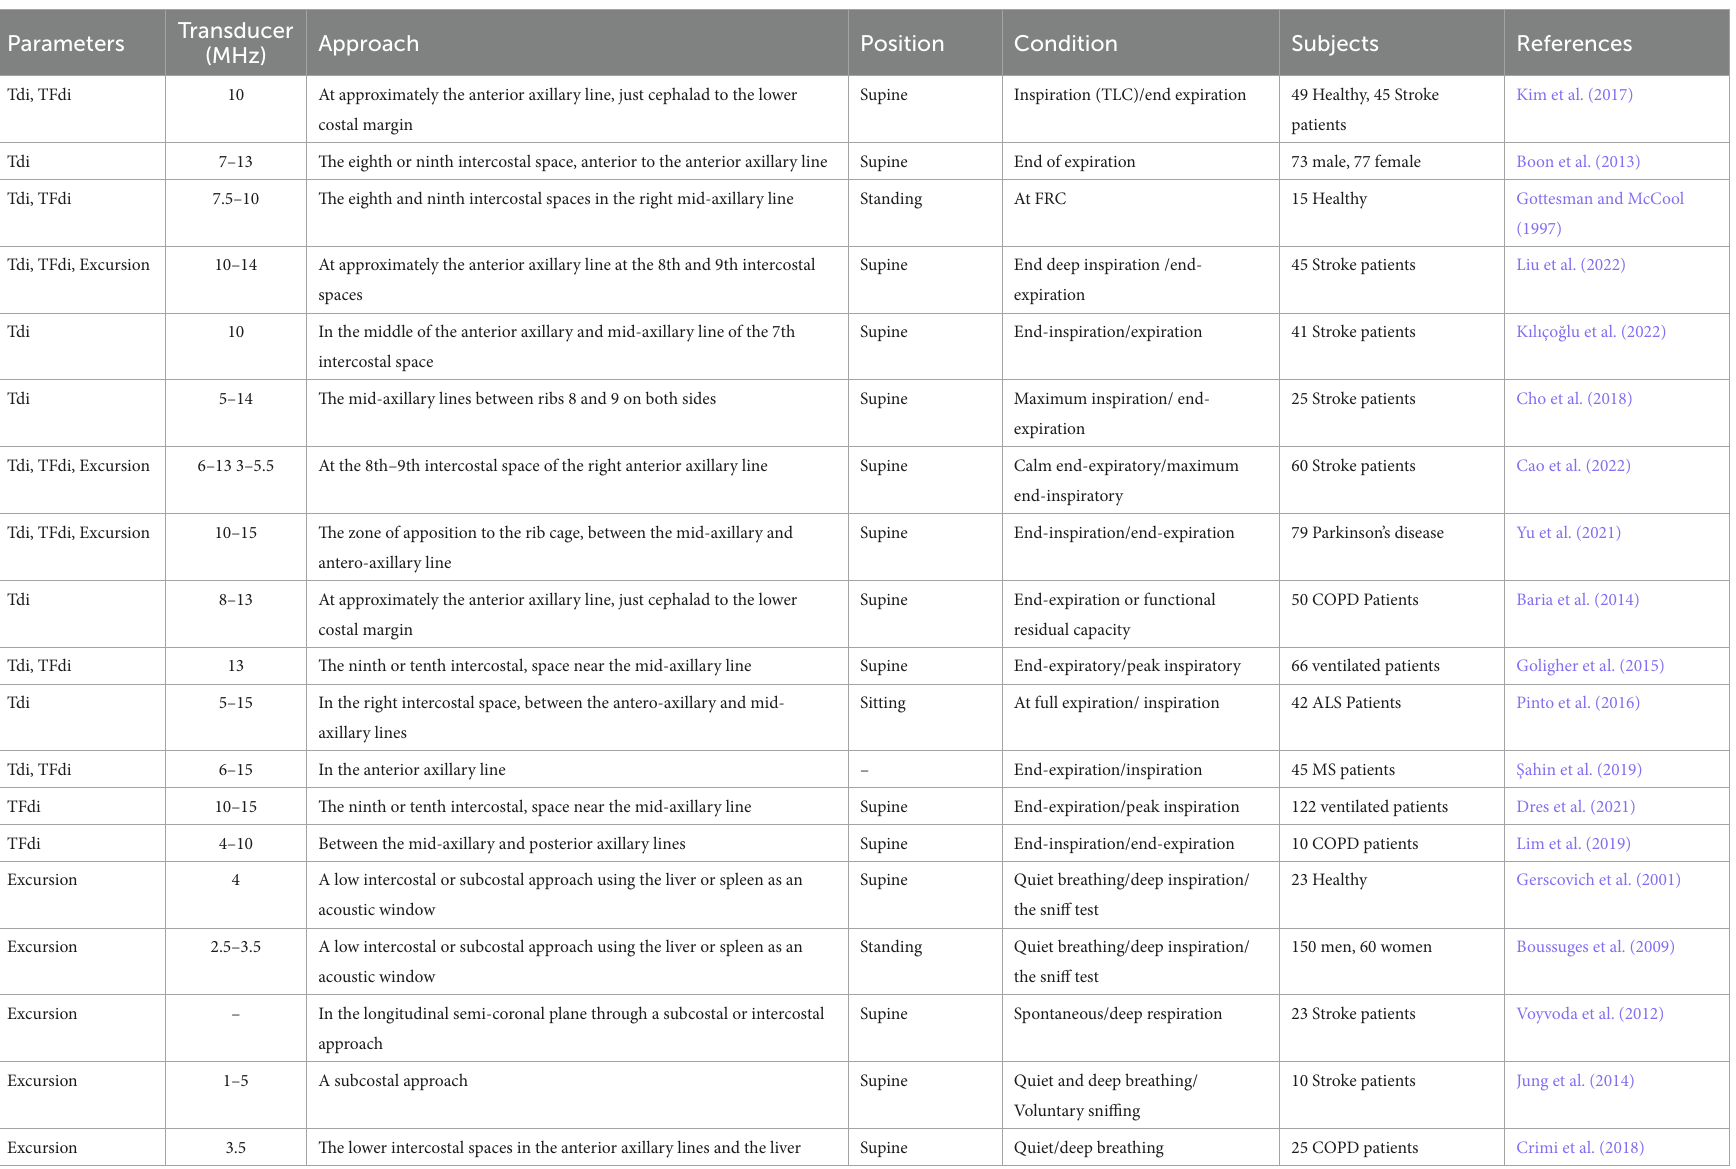
TABLE 1 Selected studies providing direct visualization of ultrasonographic assessment of the diaphragm.